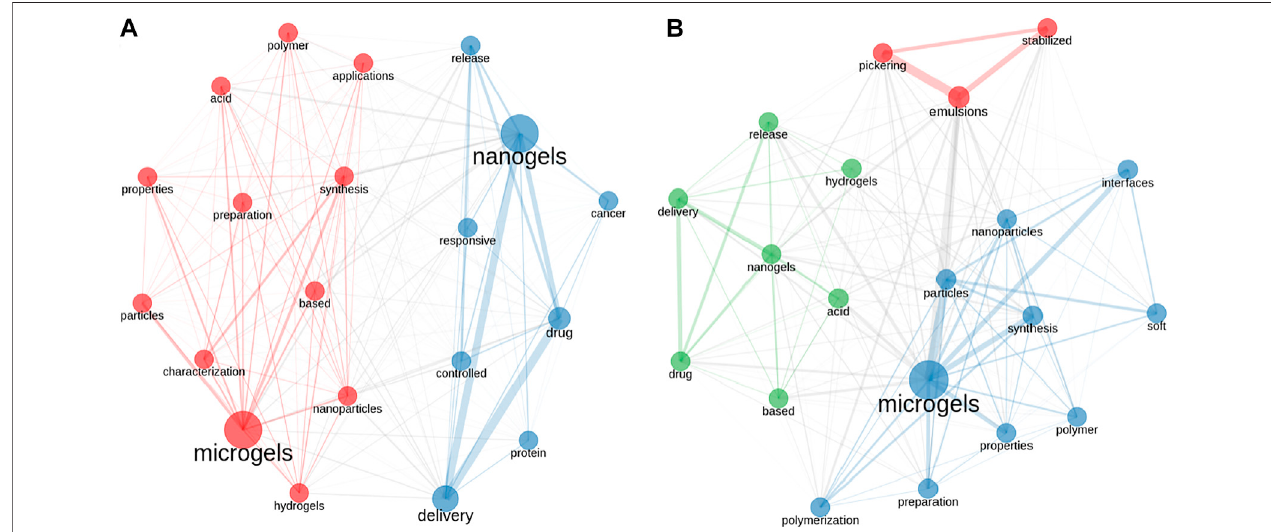
FIGURE 3 | Conceptual structure of the topic. Co-occurrence of words in titles. Bibliographic co-occurrence of the 20 most relevant words in titles between the years 2010 – 2020 for (A) the main topic “ microgels and nanogels ” and (B) the sub-topic “ microgels and nanogels at interfaces and emulsions ” . Different colors correspond to different clusters or themes within the research topic. Different size correspond to total occurrences, and thickness of links correspond to the strength of the co-occurrence. Plots are produced with Biblioshiny.